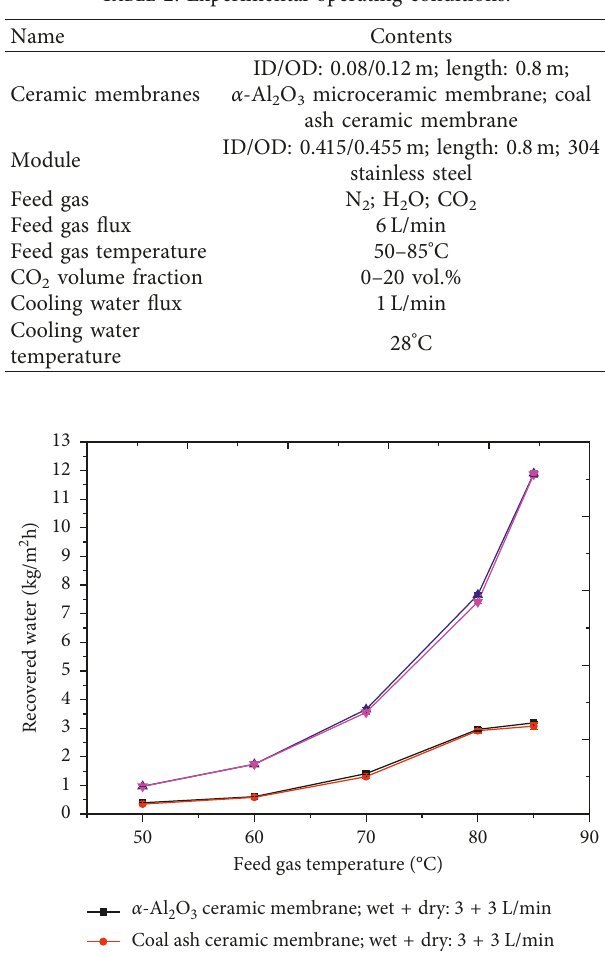
Table 2: Experimental operating conditions.